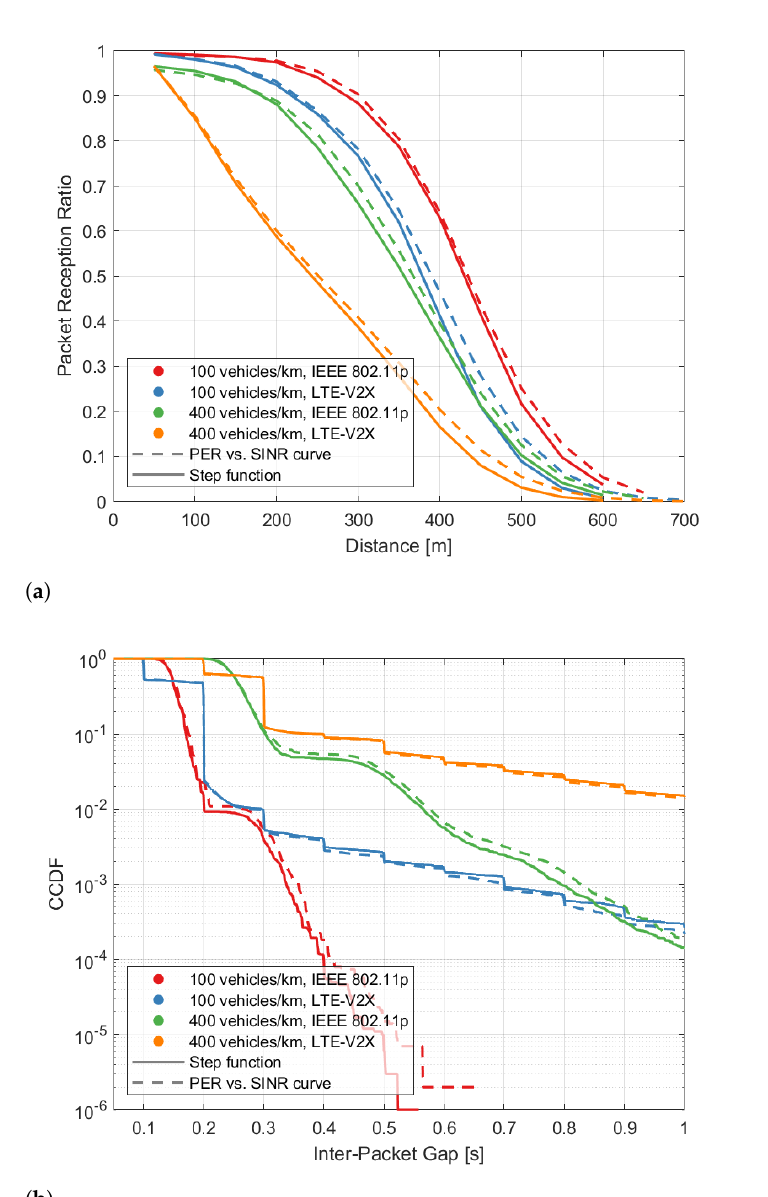
Figure 6. PRR vs. distance and CCDF of IPG obtained using the proposed step function approxima- tion (solid curves) and the PER vs. SINR curves of Figure 4 (dashed curves). Results are obtained in a highway scenario with LOS conditions. ( a ) PRR vs. distance. ( b ) CCDF of